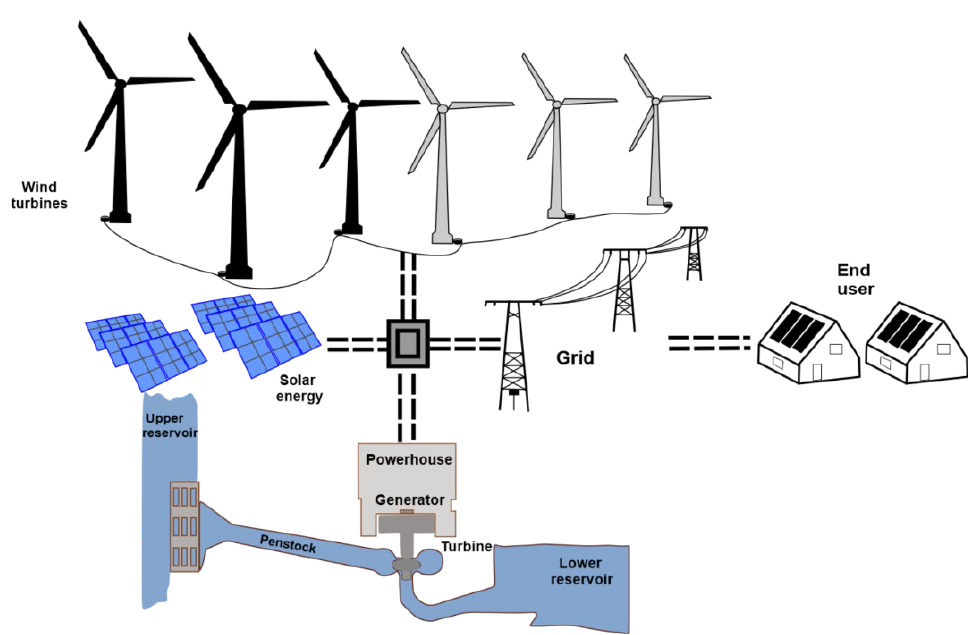
Figure 2. Schematic of hybrid pumped hydro storage system powered by excess energy from renewable energy sources and the electric grid.